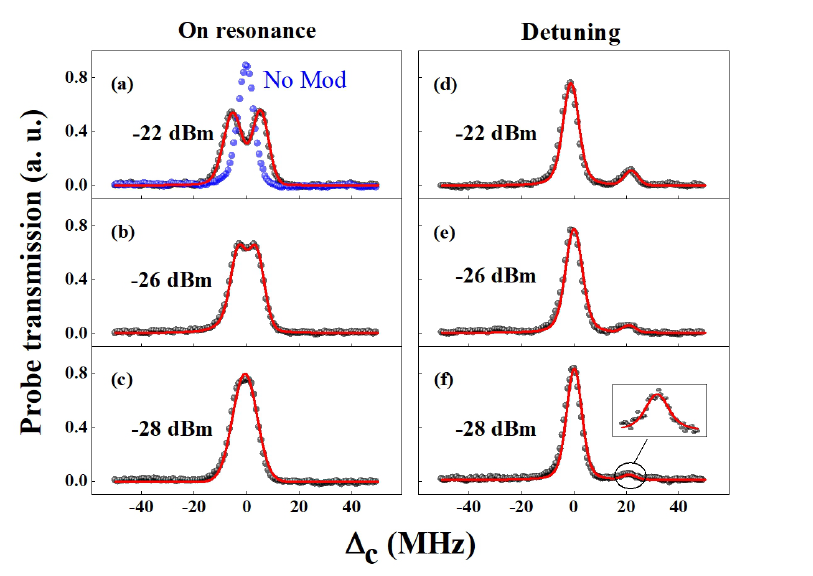
Figure 2. ( a – c ) are the AT splitting spectra as a function of the coupling laser frequency detuning ∆ c with microwave E-field powers of − 22 dBm, − 26 dBm, − 28 dBm, respectively. The microwave E-field frequency is resonance with the 57 D 5/2 –58 P 3/2 transition. The blue dots in Figure 2a is the EIT spectrum without the microwave E-field. ( d – f ) are corresponding the AT splitting spectra with the microwave E-field frequency blue detuning 20 MHz from the 57 D 5/2 –58 P 3/2 transition. The black dots represent the experimental results. The experimental data are fitted with the Voigt